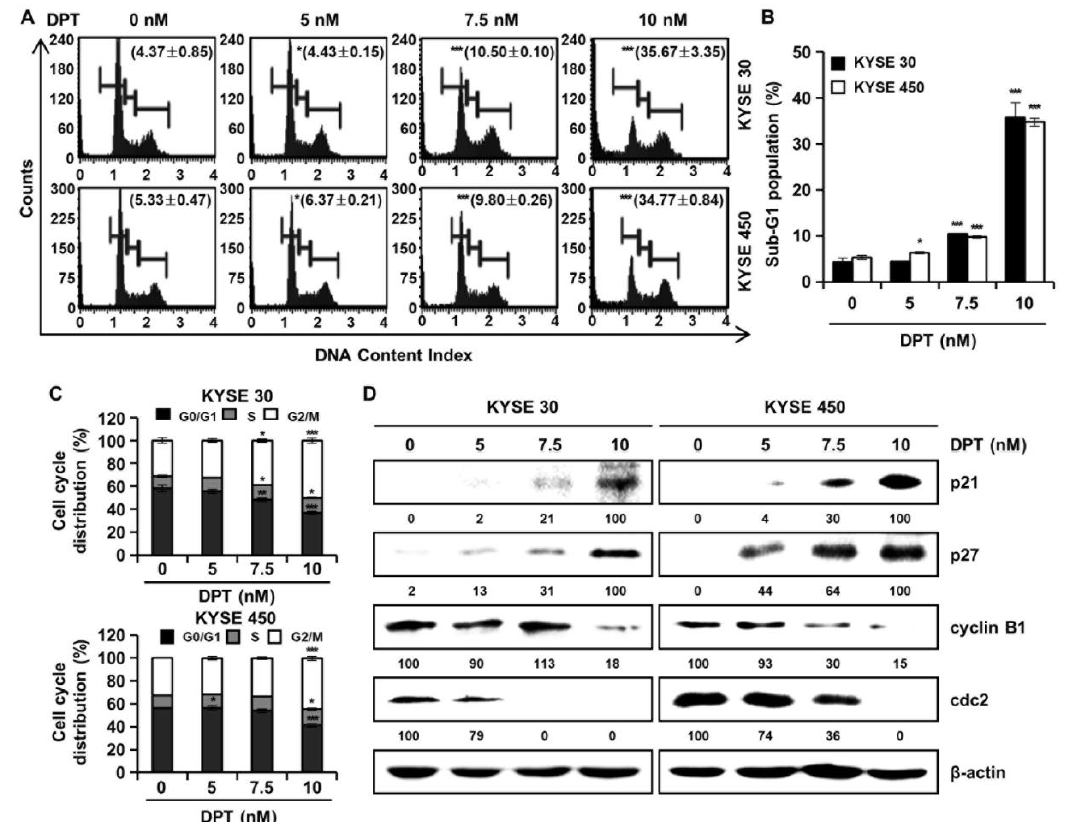
Figure 3. DPT induces G2/M phase cell cycle arrest in ESCC cells. KYSE 30 and KYSE 450 cells were